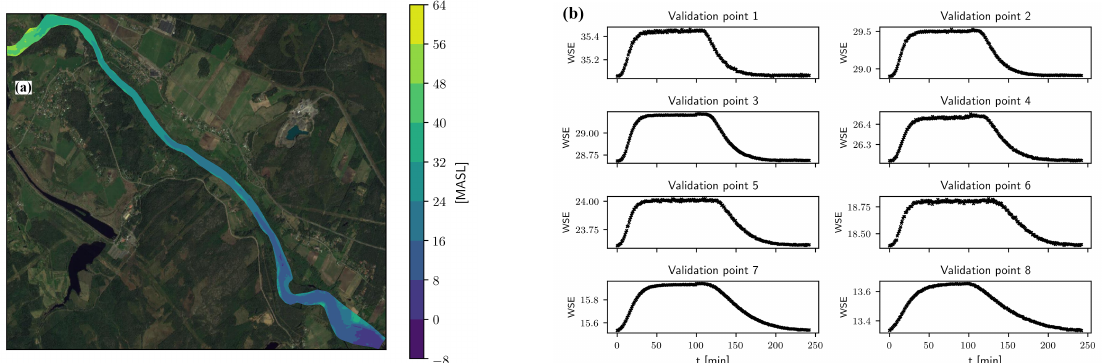
Figure 2. Field measurements in the study reach: ( a ) Digital elevation model of the study reach in meters above sea level (MASL). ( b ) Water-surface elevation (WSE) in all eight validation points during a typical increase–decrease